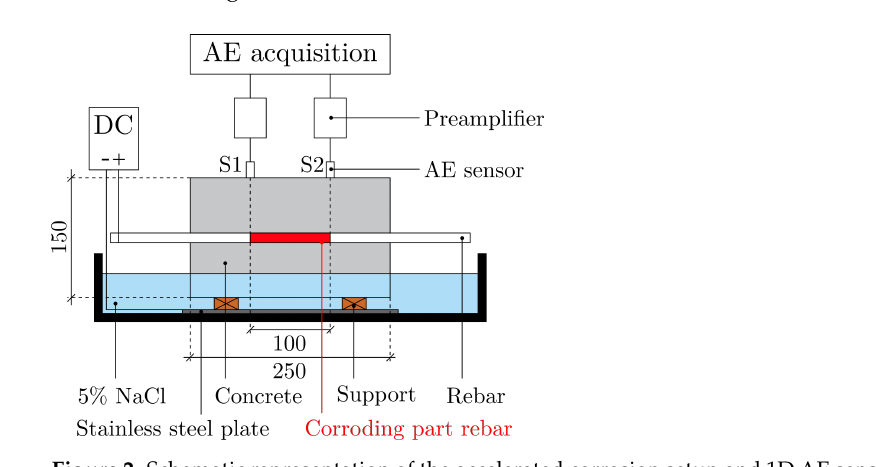
Figure 2. Schematic representation of the accelerated corrosion setup and 1D AE sensor configuration with two AE sensors